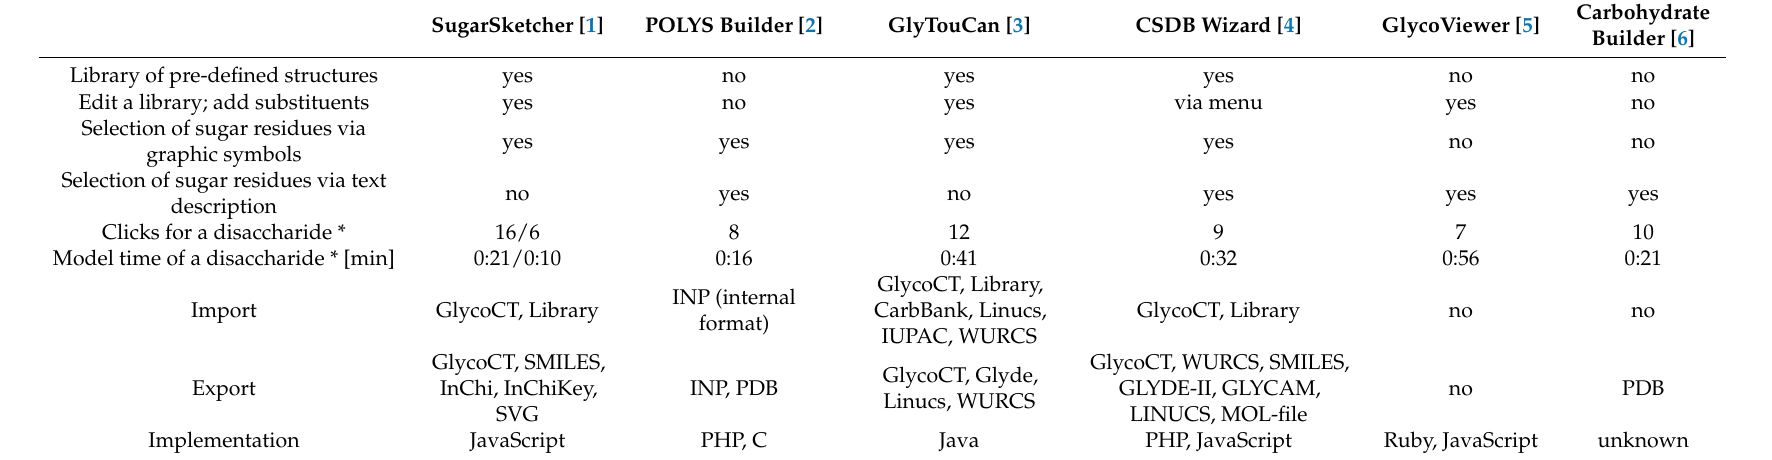
Table 1. Qualitative comparison of six tools generating SNFG-compatible glycan